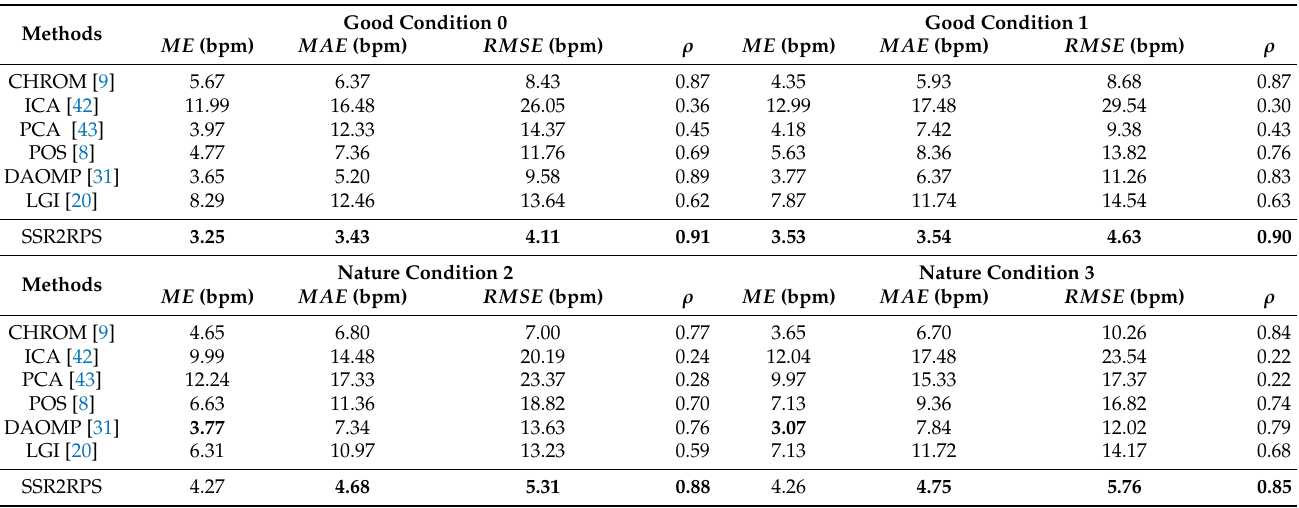
Table 2. Average heart rate prediction: comparison among different methods on different conditions of the COHFACE dataset (best performance in